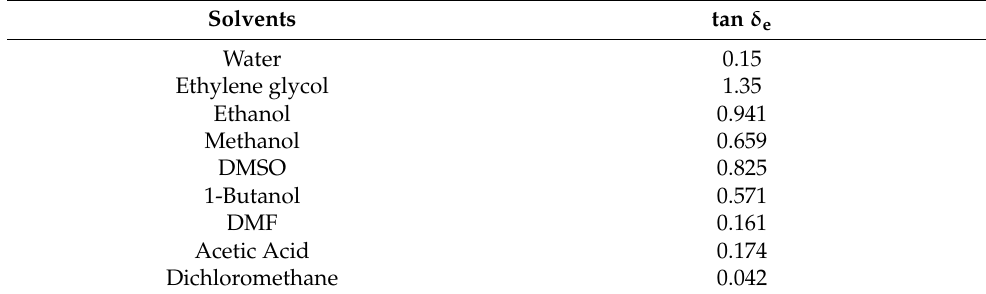
Table 2. Dielectric tangent loss (tan δ e) of various solvents. Values were obtained at 20 ◦ C and 2.45 GHz microwave frequency [56].